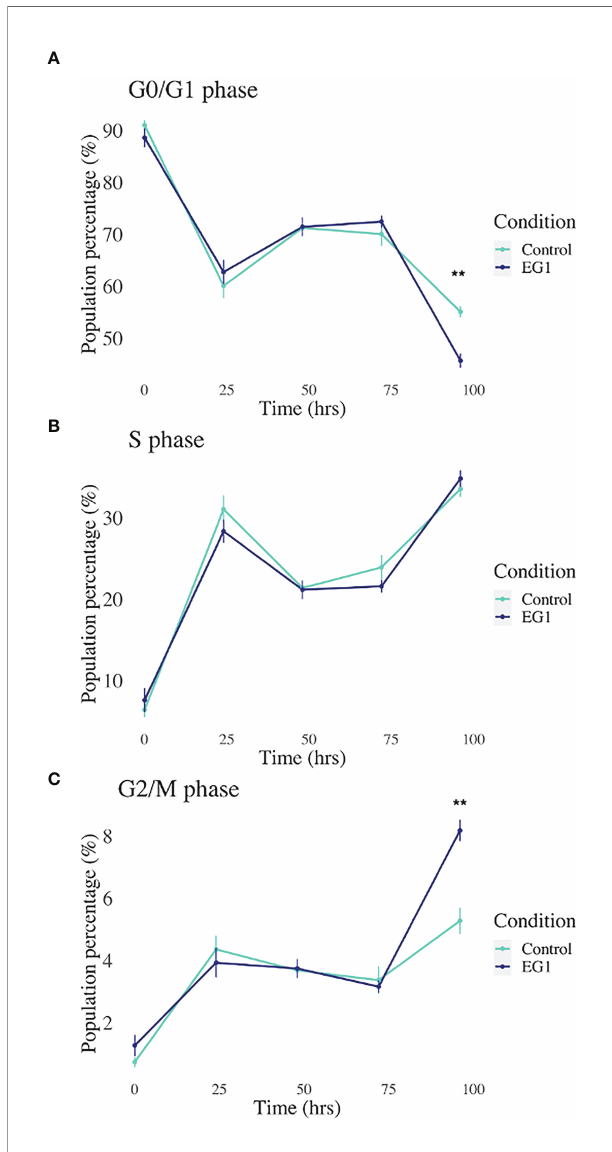
FIGURE 8 | Cell cycling by propidium iodide detection in control and 25 m mol/L EG1 treated HCT116 ’ s. Cell cycling of EG1 treated and control HCT116 cells was measured by propidium iodide (PI) staining and fl ow cytometry to identify the impact EG1 has on these cells to move through each cell cycle phase (G0/G1, S and G2/M). (A) EG1 had no impact on the percent of HCT116 cells in the G0/G1 phases between 24 hours and 72 hours. However, at 92 hours signi fi cantly fewer treated cells than controls were detected in this phase (**p < 0.05, n=6). (B) EG1 treatment over 96 hours seems to have caused no change in the ability of the HCT116 cells to enter the S phase (n=6). (C) The same pattern was observed in the G2/M phases as the G0/G1 phase where between 24 hours and 72 hours there was no difference between the EG1 treated and control populations, yet at 92 hours there were signi fi cantly more treated cells in the G2/M phases than the controls. (**p < 0.05,